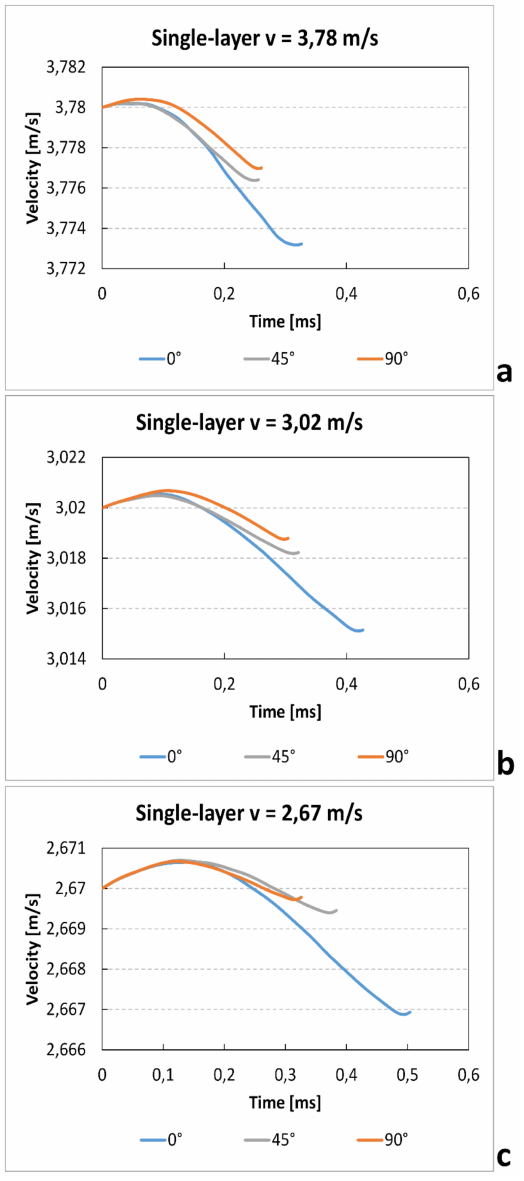
Figure 10. Single-layer velocity–time curves for di ff erent raster angle and